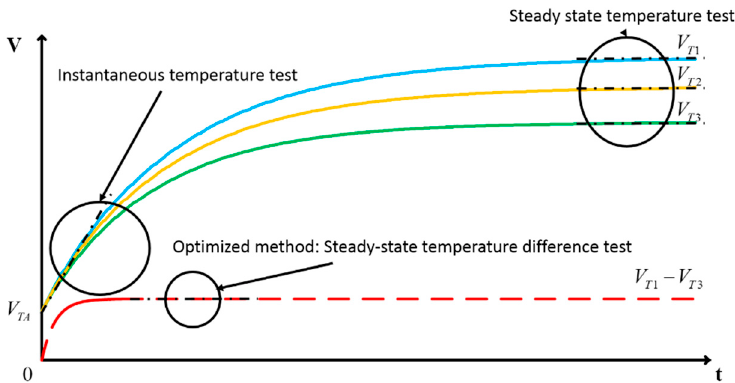
Figure 2. Schematic diagram of the traditional measurement method and the optimized measurement method.